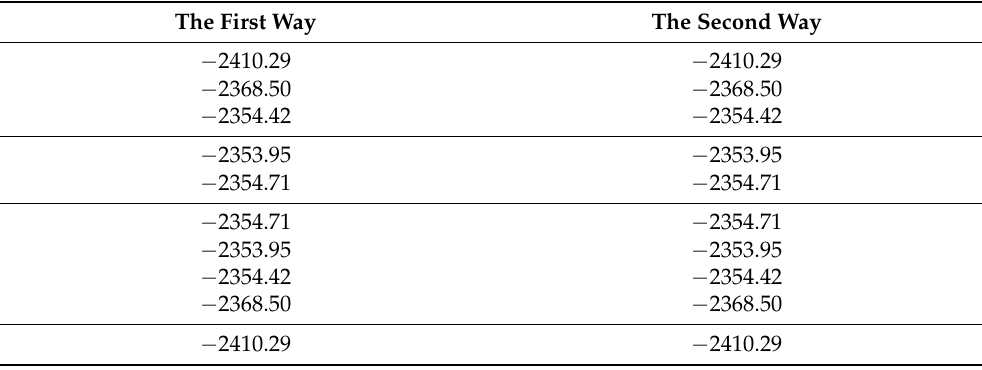
Table 3. Calculation of the potential on the segment L of the upper face of the ferromagnet after calculating the distribution σ .